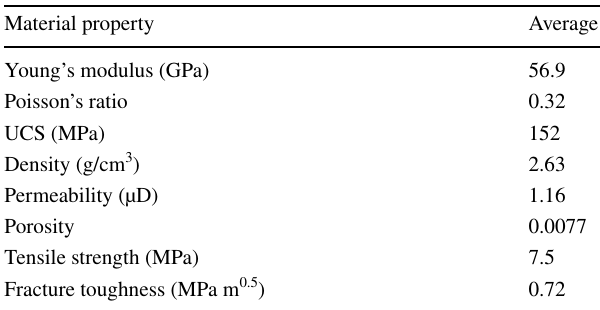
Table 1 Material properties of granite specimen used in the